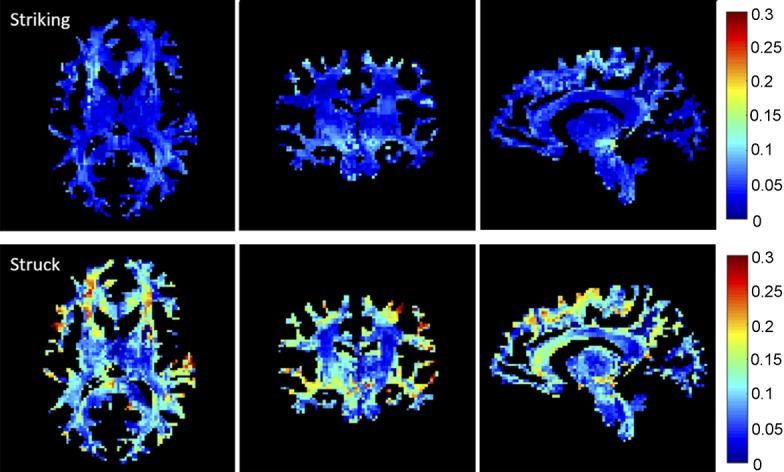
Cumulative WM fiber strains on representative orthogonal planes for a pair of striking (non-injury) and struck (concussed) athletes.